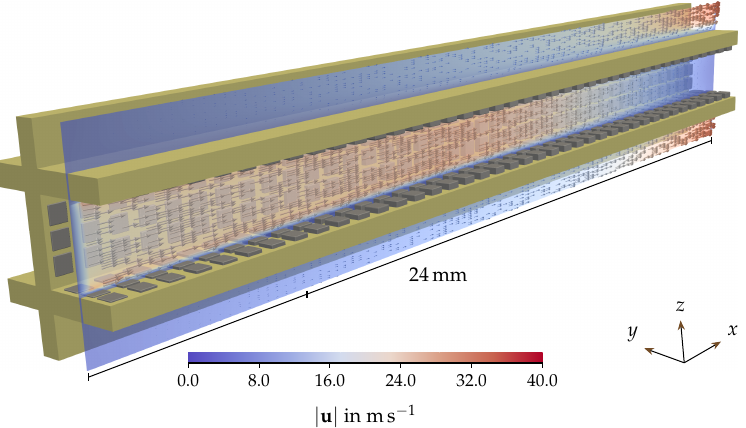
Figure 25. Flow field with fragmented PM layer assuming an increasing height over a relative channel length of x rel = 0.4 in gray. Dark yellow structures represent porous filter substrate. Colour scale indicates local velocity